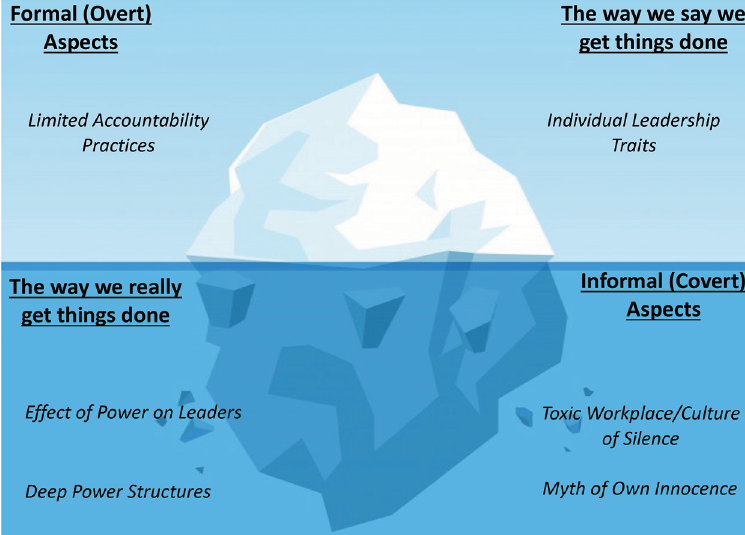
Figure 1: Drivers for abuse of power in organizations based on covert and overt culture